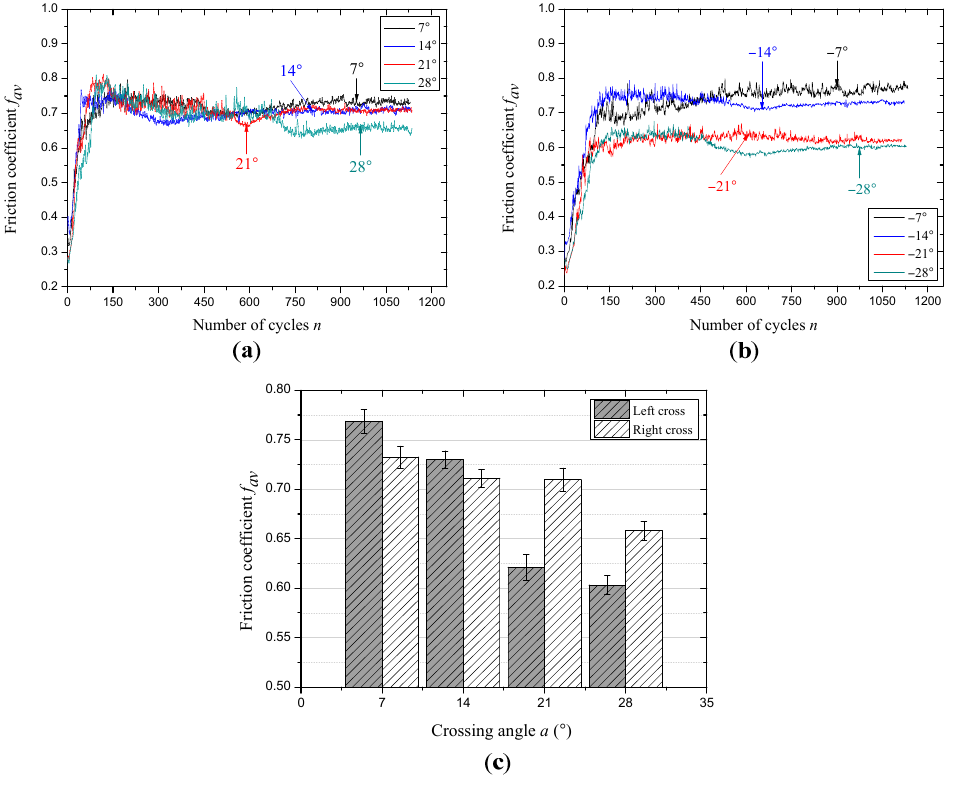
Figure 5. The evolution of the friction coefficient under different sliding conditions ( x : 10 mm; v : 6 mm/s). ( a ) Right cross contact; ( b ) left cross contact and ( c ) the average values of the friction coefficient in the steady-state period.